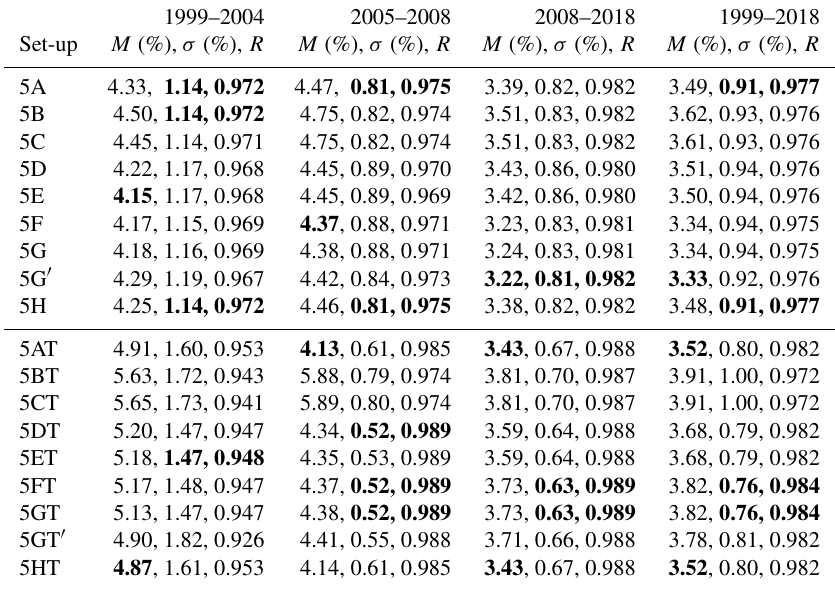
Table 4. Summary of statistics for the Brewer–FTIR comparison for the set-ups 5A, 5AT, 5B, 5BT, 5C, 5CT, 5D, 5DT, 5E, 5ET, 5F, 5FT, 5G, 5GT, 5H, and 5HT: median ( M , in %) and standard deviation ( σ , in %) of the RD (FTIR–Brewer) and Pearson correlation coefficient ( R ) for the periods 1999–2004, 2005–May 2008, and June 2008–2018 and for the entire time series (1999–2018). The number of coincident FTIR–Brewer measurements is 89, 169, and 1722 for the three periods, respectively, and 1980 for the whole dataset. Note that the set-ups 5G (cid:48) and 5GT (cid:48) stand for the FTIR O 3 data estimated using the retrieved ILS parameters from the set-ups 5G and 5GT, respectively, but averaged on a annual basis (see details in the text). The strategies showing the best performance (smallest M and σ , and largest R ) are highlighted in bold for each